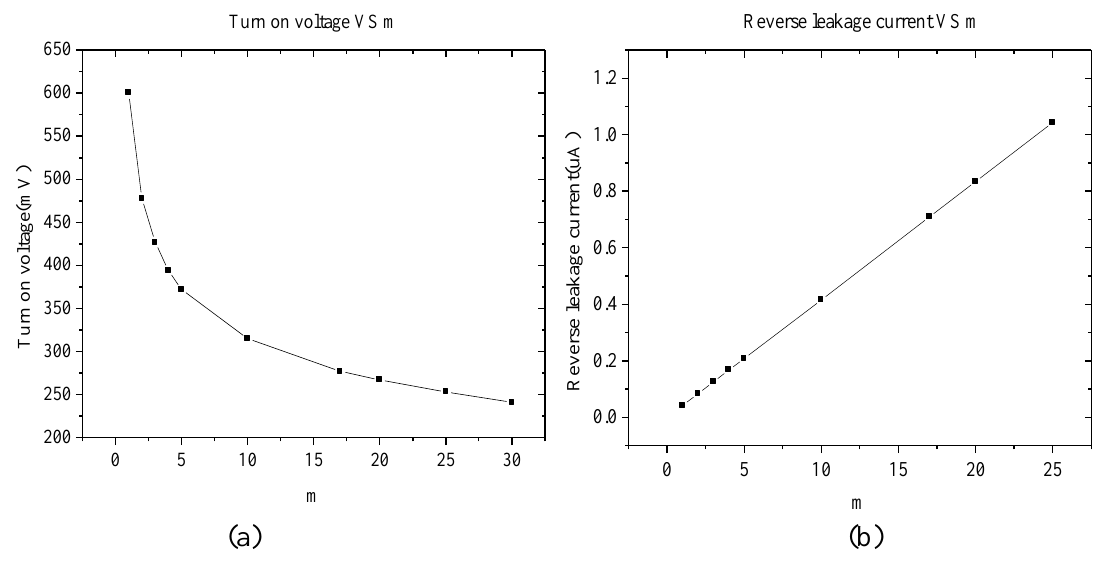
Figure 8. Characteristic curve of diode-connected CMOS (a) Turn-on voltage with different m (b) Reverse leakage current with different m